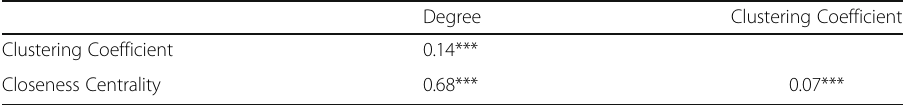
Degree Clustering Coefficient